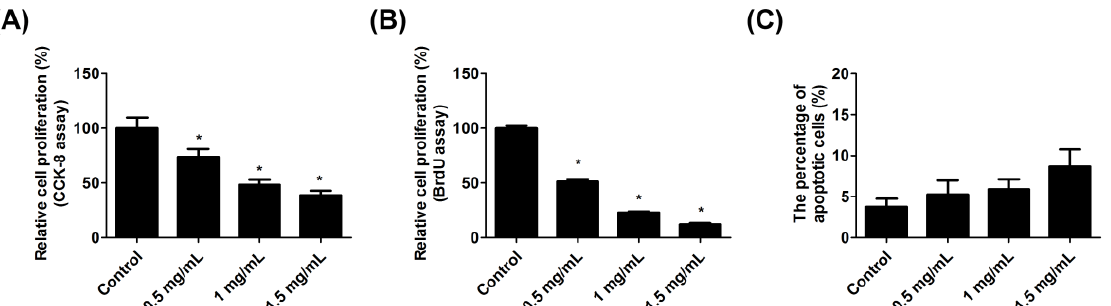
Figure 2. Lidocaine reduced tendon cell proliferation. Tendon cells were either left untreated or were treated with lidocaine (0.5, 1.0, or 1.5 mg/mL) for 24 h. ( A ) The cell viability was determined through the CCK-8 assay. ( B ) The cell proliferation was determined by BrdU assay. ( C ) The cell apoptosis was determined by Annexin V and propidium iodide (PI) stain. Data are presented as the means ± standard errors of the mean of three independent experiments. * p < 0.05.